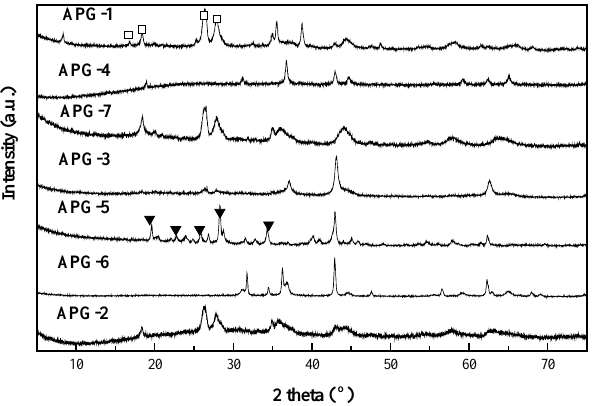
Figure 4. SO 2 pick-up efficiency of sulfur transfer catalysts with different oxidation active components. Figure 5 is the XRD Figure of sulfur transfer agent with different oxidative active components after reaction. The spectrogram demonstrates that CuO phase and Mg(Al)O phase in APG-1 sample still exist, and new crystalline phase Cu 1 ´ x Al x (SO 4 ) 0.5 and MgSO 4 come out. The Mg(Al)O crystalline phase disappears in APG-7 and APG-2 samples but new crystalline phase MgSO 4 occurs. There is still Mg(Al)O phase in APG-4 and APG-6 samples but sulfate does not exist. Taking desulfurization performance analysis into account, on one hand, it demonstrates that magnesium oxide is the active site of SO 2 adsorption and forms magnesium sulfate; on the other hand, transition metal forms synergistic effect with magnesium and aluminum so that samples with copper have good desulfurization performance while samples with barium and cobalt have poorest desulfurization performance.